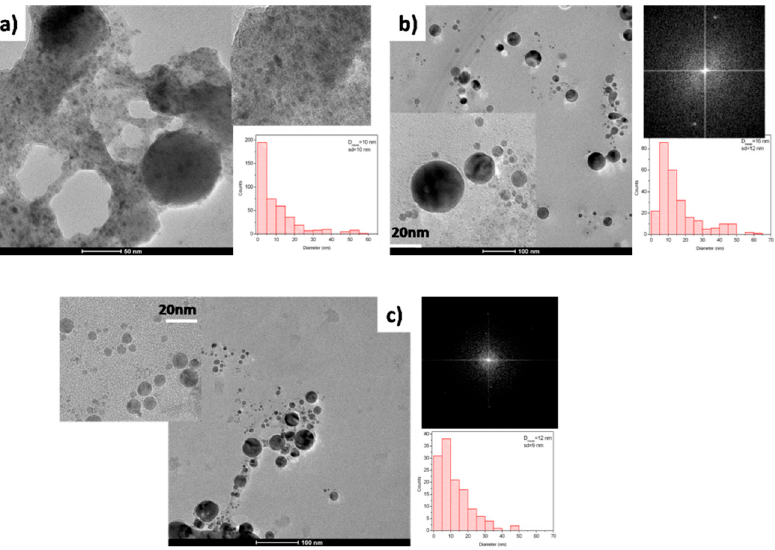
Figure 3. TEM images and particles size distributions of nanoparticles obtained by laser ablation of Mo in water ( a ), acetone ( b ) and toluene ( c ).